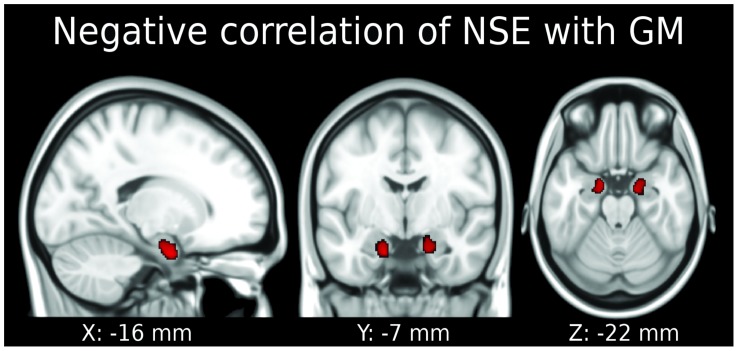
Gray matter density (GM) in both amygdalae and both most anterior hippocampi is correlated with serum neuron-specific enolase (NSE) in the female brain.No significant results were obtained for male subjects. p<0.05 family wise error was applied, reported coordinates are MNI coordinates. Neurological convention (left side of the brain is presented on the left).